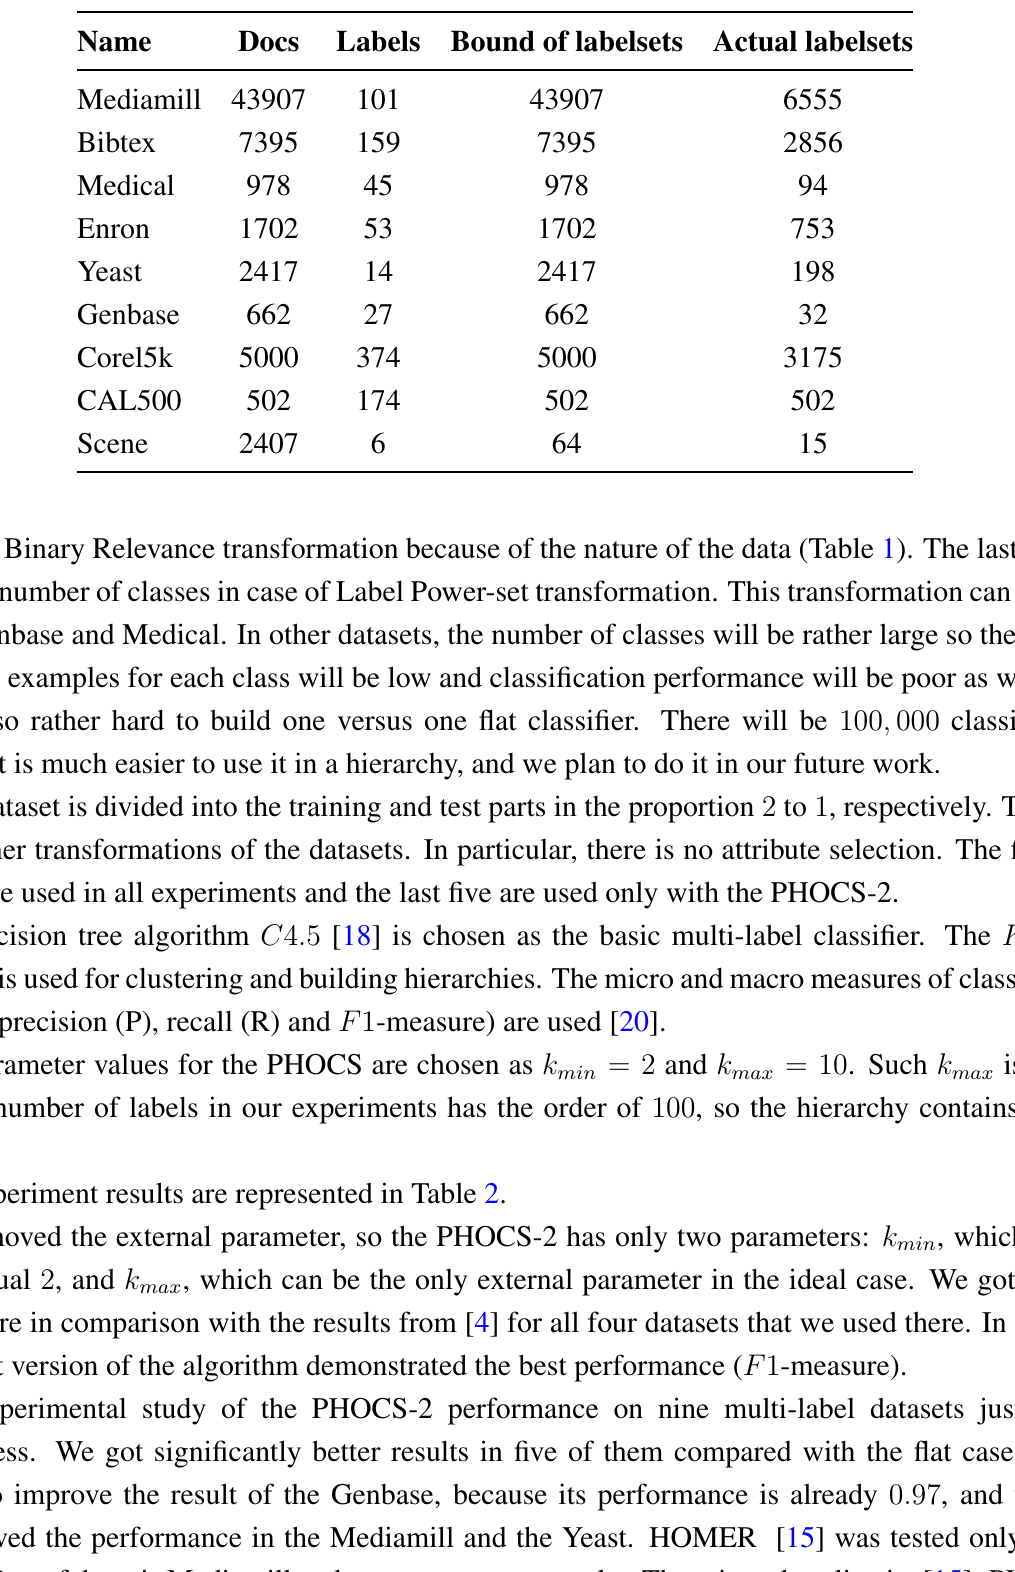
Table 1. Multi-Label Datasets and Their